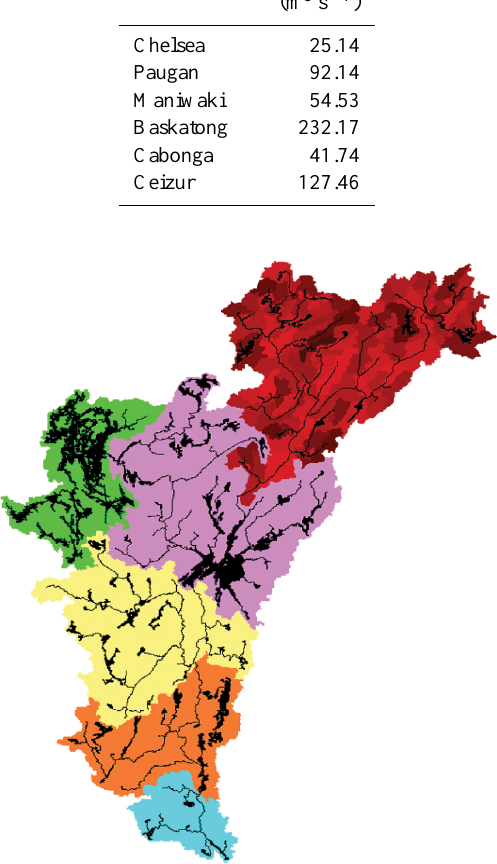
Fig. 1. The Gatineau watershed divided in six sub-catchments: Ceizur (red, 6840km 2 ), Cabonga (green, 2662km 2 ), Baskatong (purple, 6200km 2 ), Maniwaki (yellow, 4145km 2 ), Paugan (orange, 2790km 2 ) and Chelsea (turquoise, 1148km 2